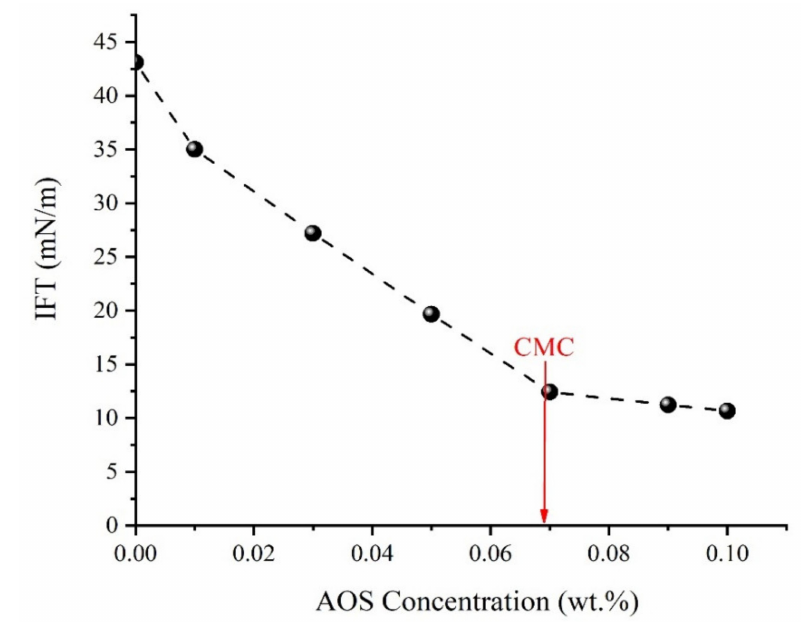
Figure 11. Crude oil–aqueous solution IFT at di ff erent concentrations of AOS